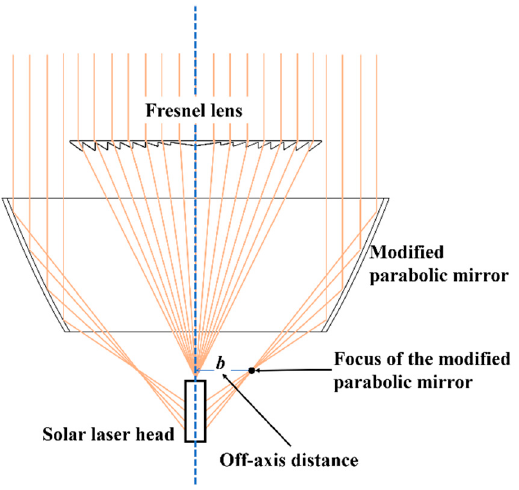
Figure 2. Schematic of the primary concentrator consisting of a Fresnel lens and modified parabolic mirror.